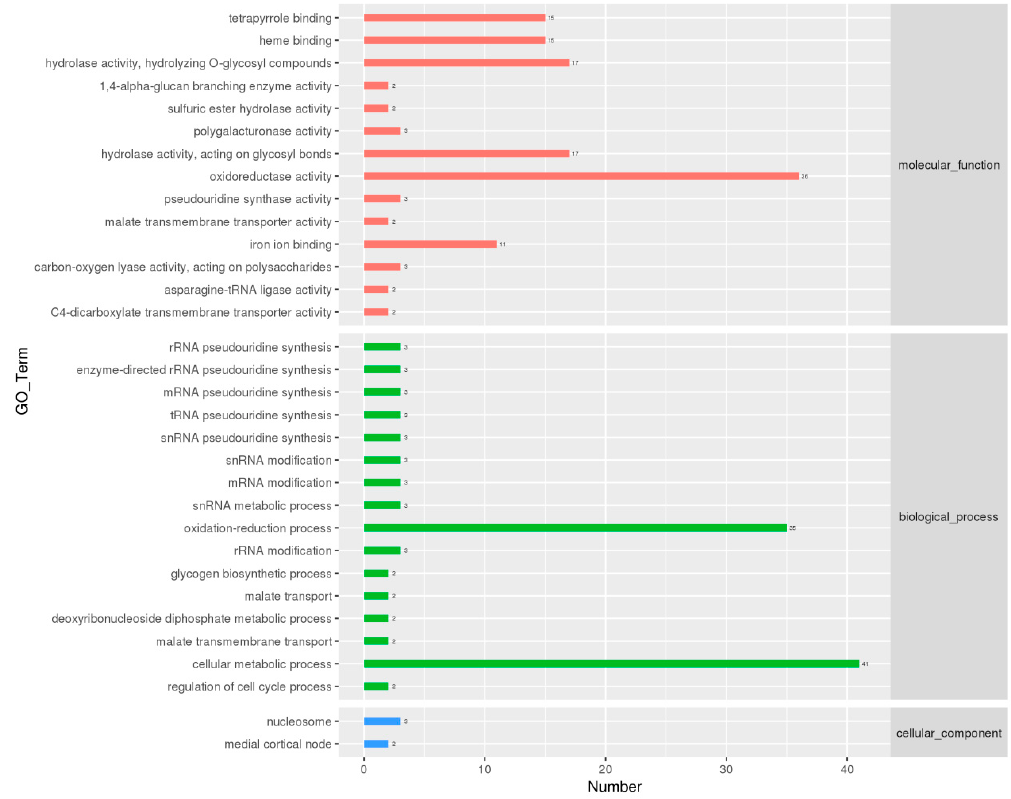
Figure 4. GO functional classification of differentially expressed genes. The green bars represent biological process; yellow bars represent cellular component; blue bars represent molecular function.